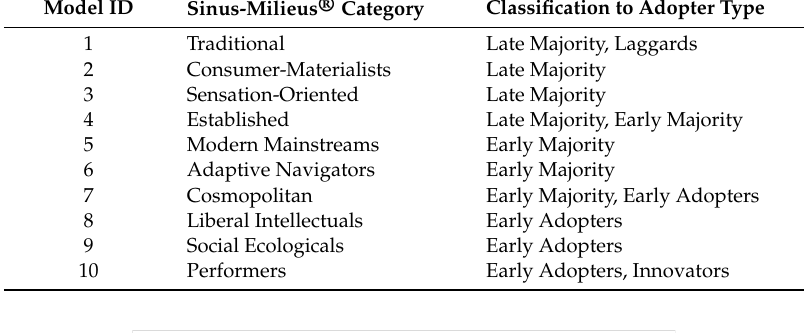
Table 1. Mapping of IDs used in the model to Sinus-Milieus ® category and classification of Sinus-Milieus ® categories to the different types of adopters.